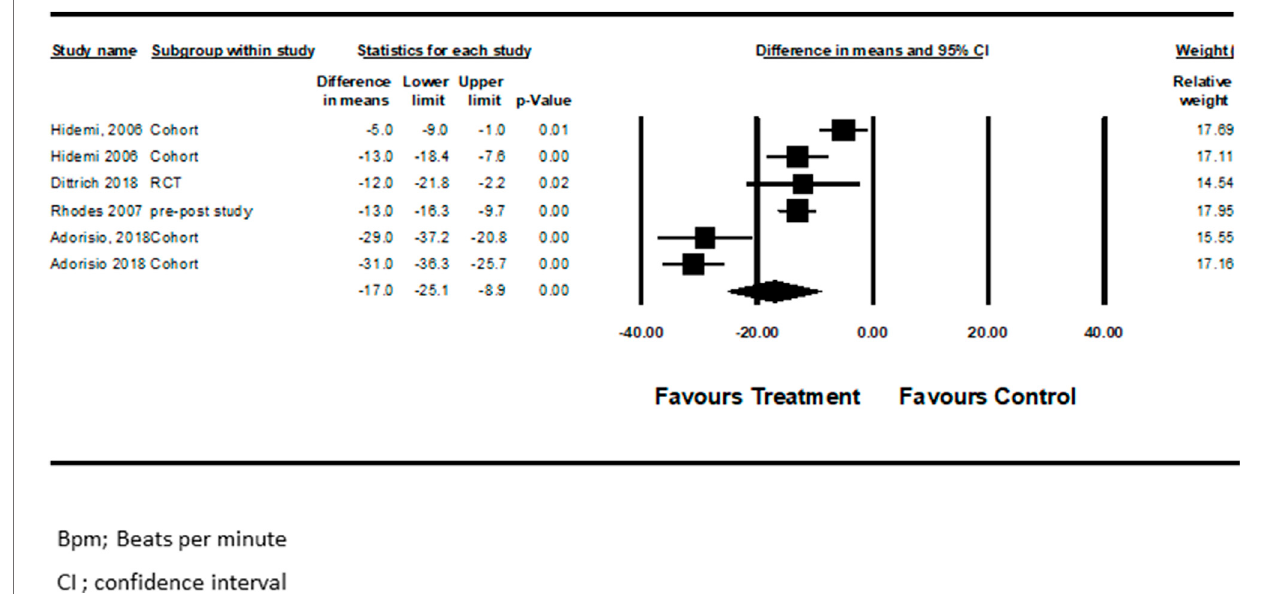
FIGURE 1 | The actual differences in bpm following HF treatment versus